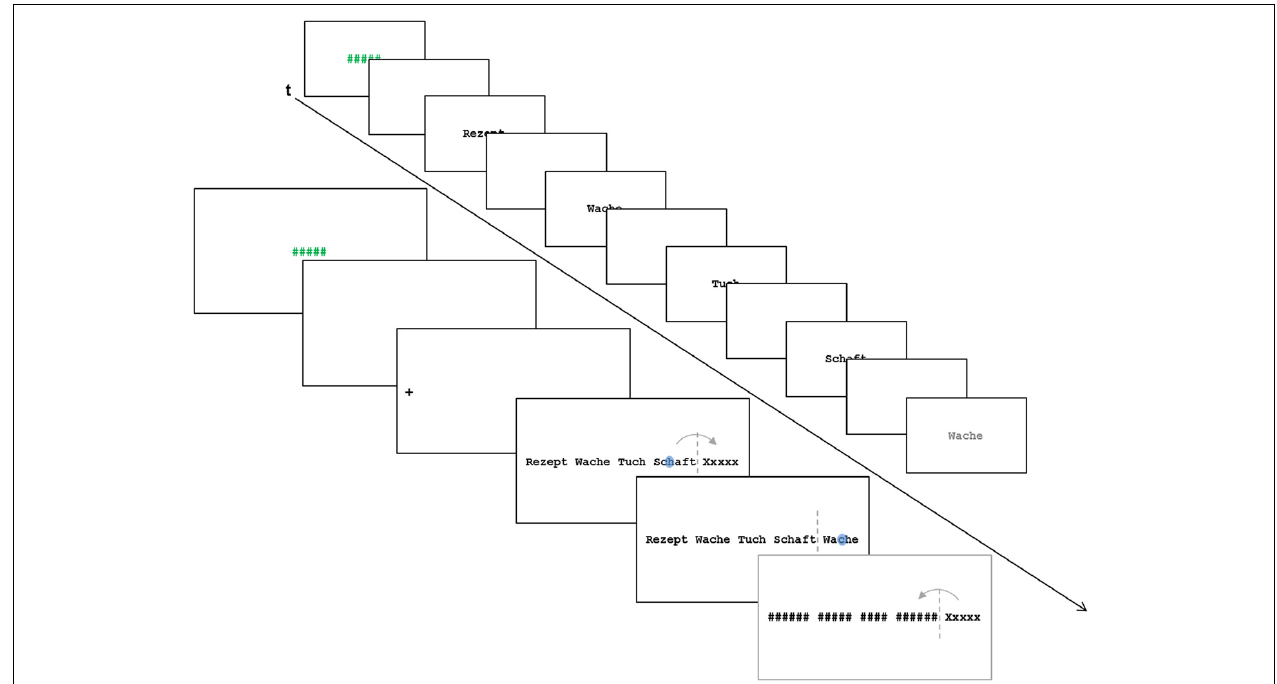
FIGURE 1 | Schematic illustration of the events in a trial of the X-mask FRP condition and a trial of the ERP conditions. The blue dot in the illustration of the FRP condition represents a fixation; the arrow represents a saccade which crosses the invisible boundary (dashed line) before the target word. In the FRP conditions, the time-points for averaging the FRPs were the